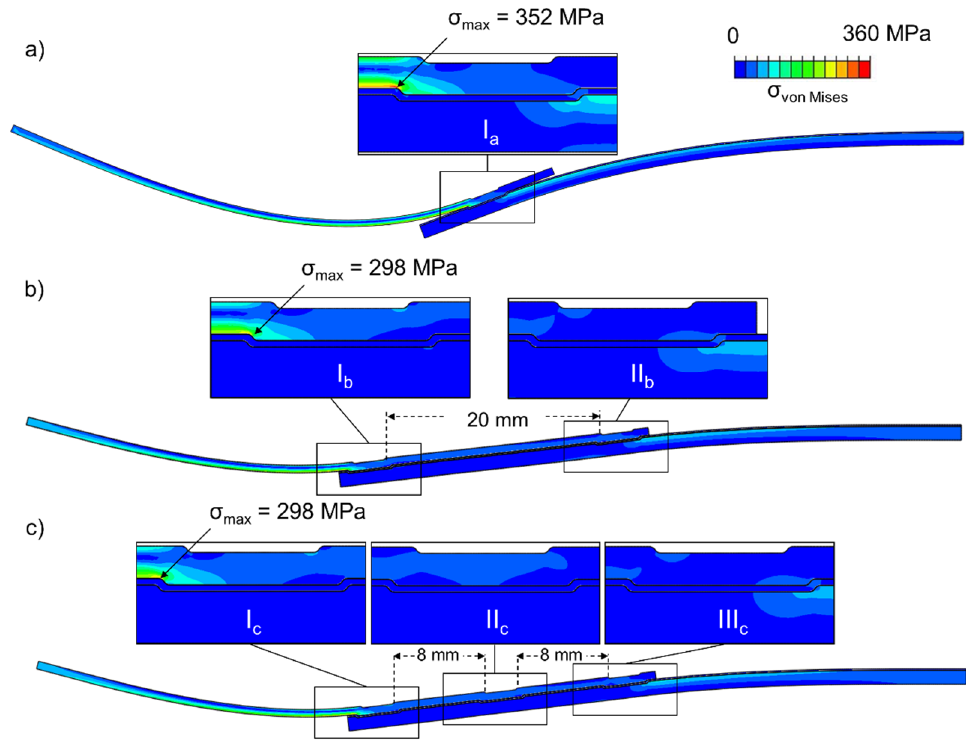
Figure 9. FE model of a Ti6Al4V/PEEK/CF-PEEK sheet joint: Von Mises stress distribution and von Mises stress maxima under a tensile load of 6 kN for ( a ) one, ( b ) two and ( c ) three weld seams.